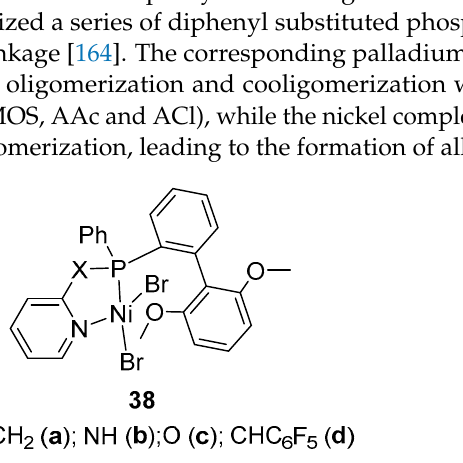
Figure 32. Diphenyl-substituted phosphine-pyridine catalysts 38a – d with CH 2 , NH and O linkage. Brookhart et al. reported a novel bulky monodentate phosphine tri-1-adamantylphosphine-nickel precursor [Ad 3 PNiBr 3 ] − [Ad 3 PH] + 39 (Figure 33) [165], which could catalyze the polymerization of ethylene to ultrahigh-molecular-weight, nearly linear polyethylene ( M n up to 1.68 × 10 6 g mol − 1 ) with initial activities reaching 3.7 million turnovers per h − 1 at 10 ◦ C, and copolymerize ethylene with α -olefins such as 1-hexene, 1-octadecene, and tert -butyldimethyl(dec-9-en-1-yloxy) silane with no decrease in activity. However, the catalyst was rapidly deactivated at higher temperatures, and both the catalytic activity and polymer molecular weight dropped